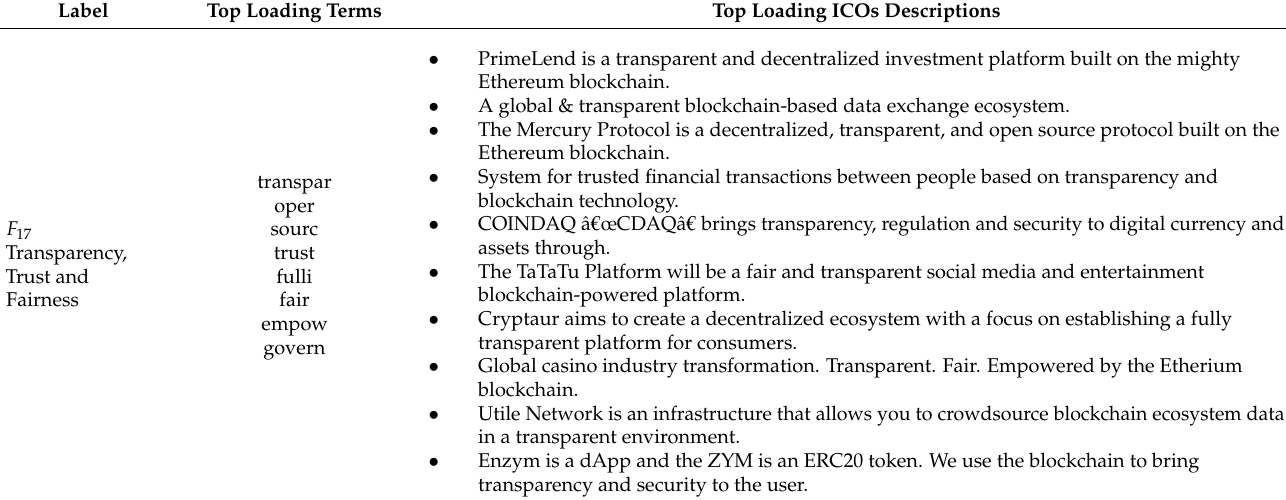
Table A17. Transparency, Trust and